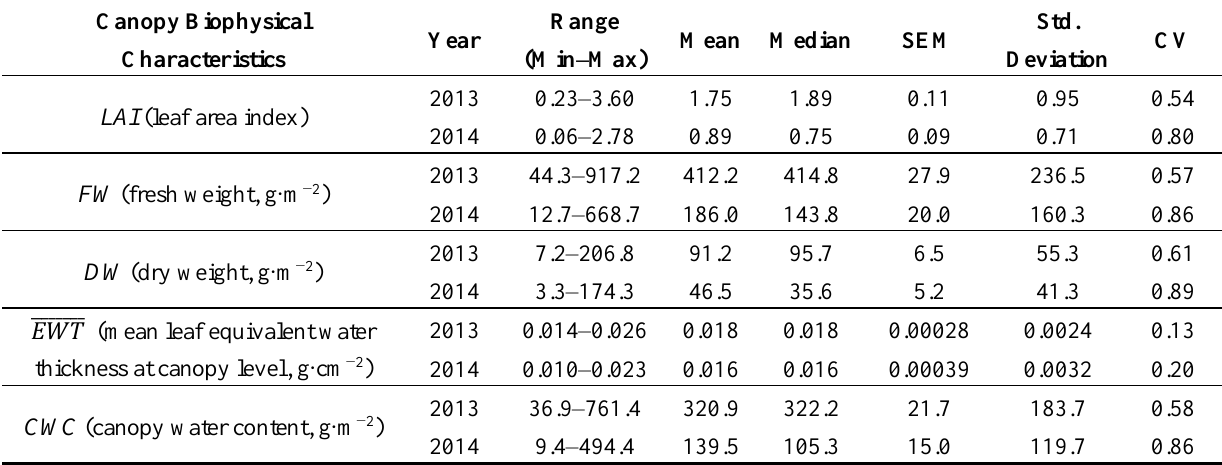
Table 4. Summary statistics of canopy biophysical characteristics of maize acquired in situ under different irrigation treatments during the 2013 ( n = 72) and 2014 ( n = 64) growing